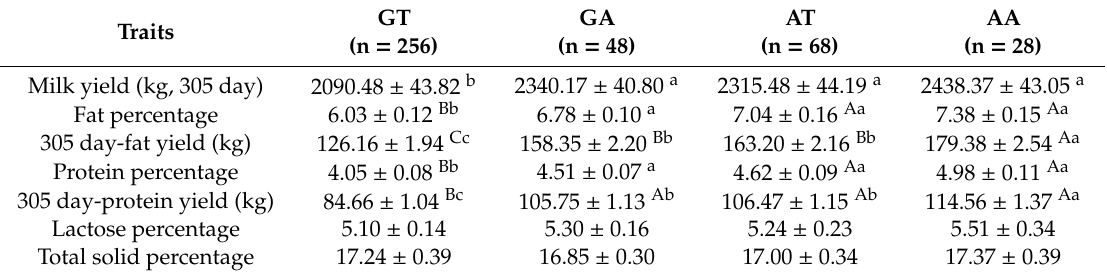
Table 5. Association between di ff erent haplotypes (GT, GA, AT, and AA) of GHR and milk yield and quality